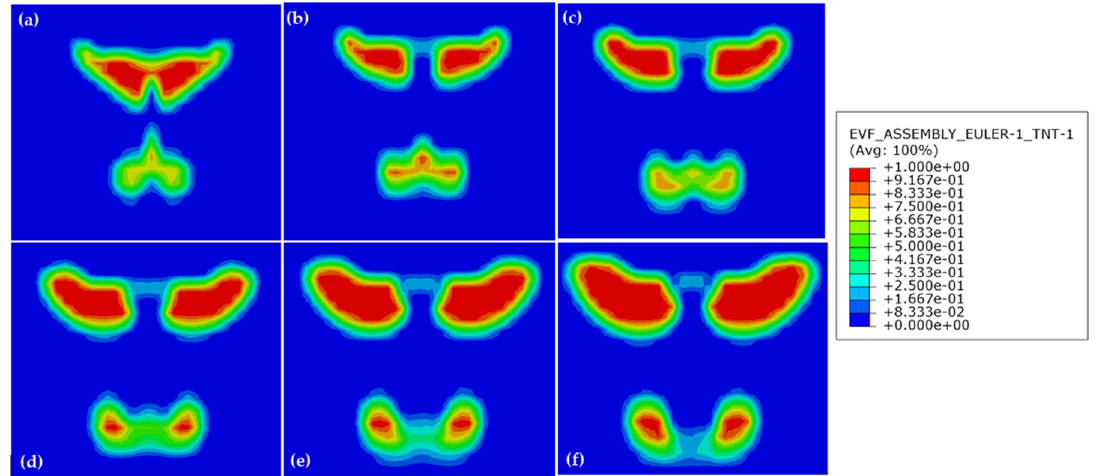
Figure 25. Simulated bubble motion during the collapse phase at: ( a ) t = 6.1 ms; ( b ) t = 6.2 ms; ( c ) t = 6.3 ms; ( d ) t = 6.4 ms; ( e ) t = 6.5 ms; and ( f ) t = 6.6 ms.